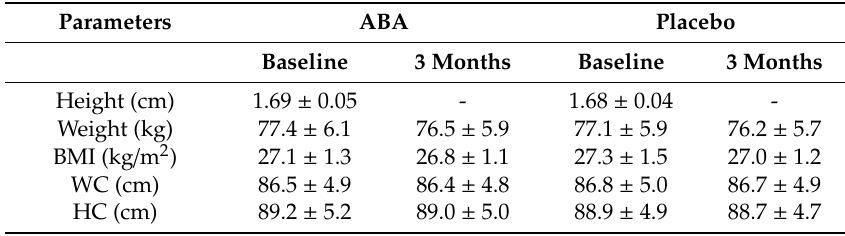
Table 2. Baseline, and 3-month anthropometric and biochemical parameters of patients during abscisic acid (ABA) treatment and placebo.